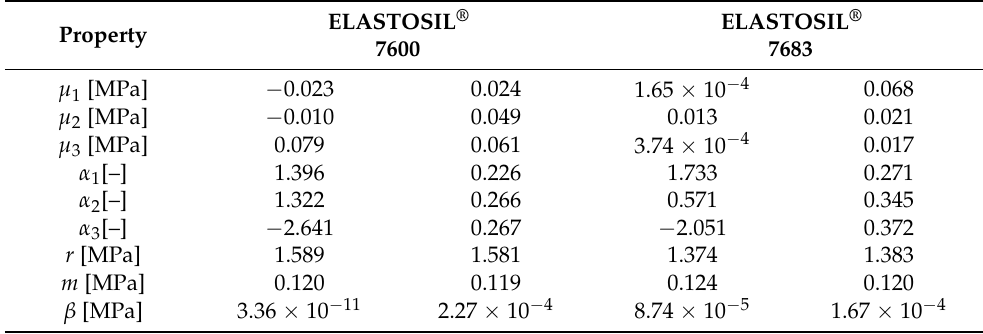
Table 5. Summary of constitutive constants provided by the calibration process numerical solution- based solvers for Ogden–Roxburgh model ( N = 3) via Ansys (right) and Abaqus (left) solvers. Property